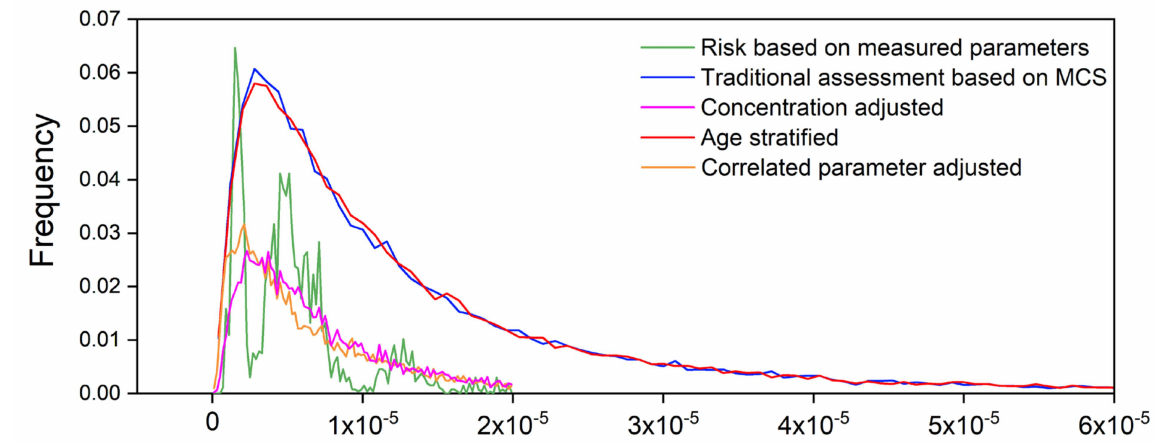
Figure 7. Risk distributions of five assessment